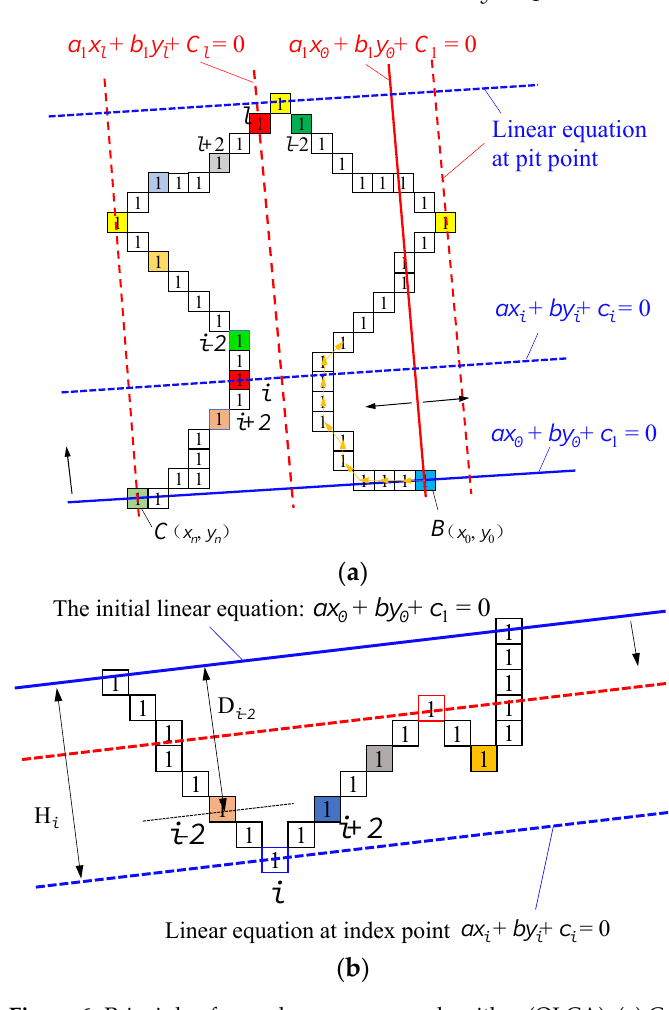
Figure 6. Principle of open ‐ loop crossover algorithm (OLCA). ( a ) Constraint principle with front and back points on the same side. ( b ) Principle of the distance constraint condition.